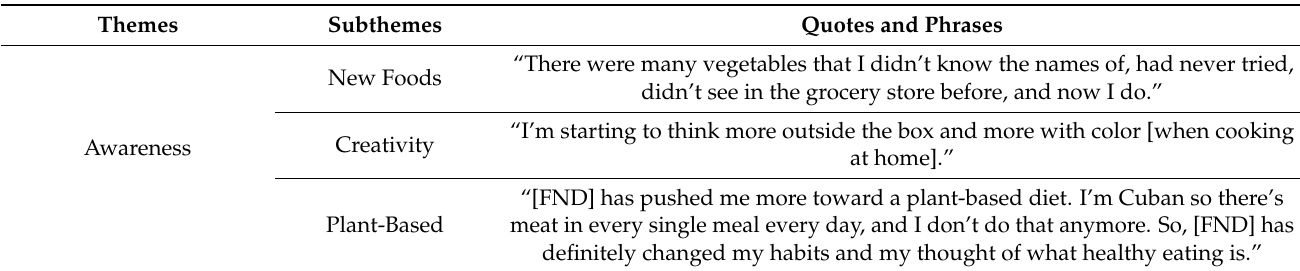
Table A3. Visual data display of themes, subthemes, and representative quotes of volunteers’ experiences.